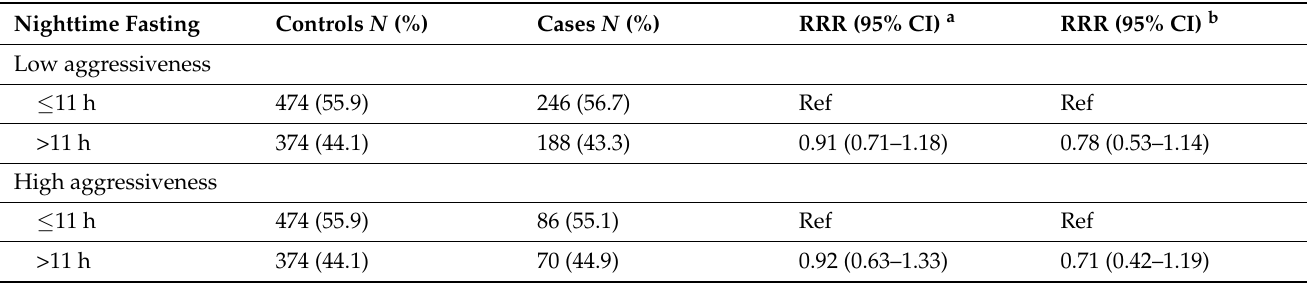
Table 7. Association of nighttime fasting and prostate cancer relative risk by cancer subtypes (missing for 17 cases). Nighttime